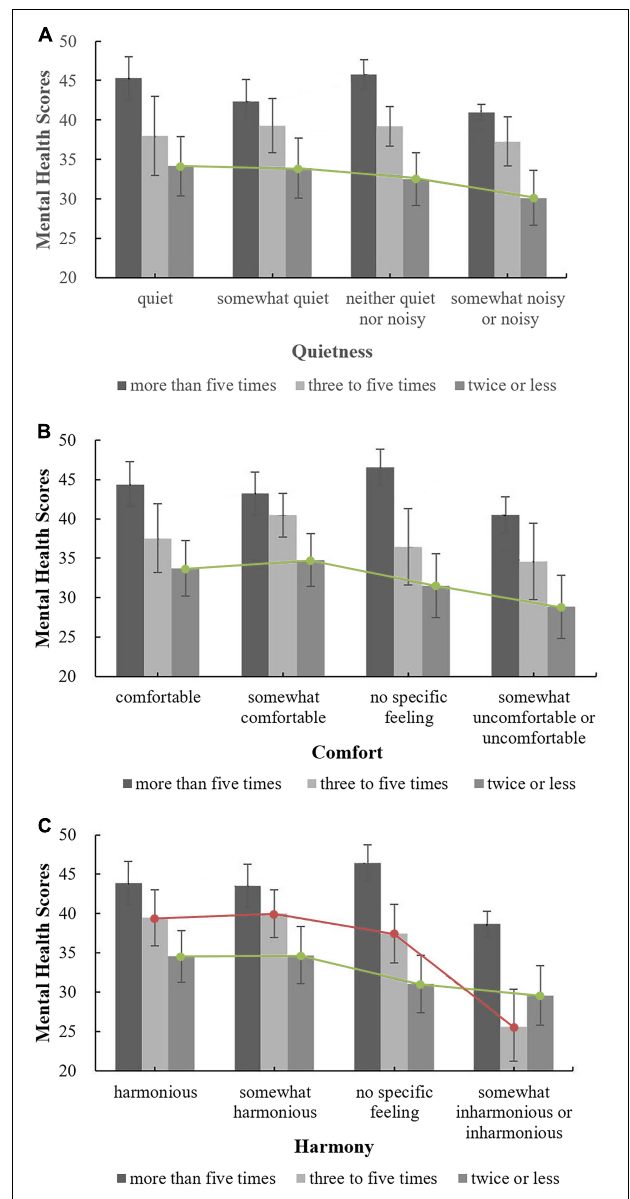
FIGURE 4 | The relationships between the evaluations of the overall acoustic environment and mental health by level of belief in Buddhist thought. (A) Quietness; (B) Comfort; (C) Harmony.